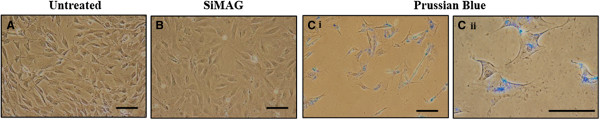
Evaluation of morphology and SiMAG uptake by mMSCs. A) Unlabelled mMSCs, B) SiMAG-labelled mMSCs, C) Prussian blue stain of SiMAG-labelled cells; (i) x 20 magnification, (ii) x 40 magnification. Bars =100 μm. mMSC, murine mesenchymal stem cells.